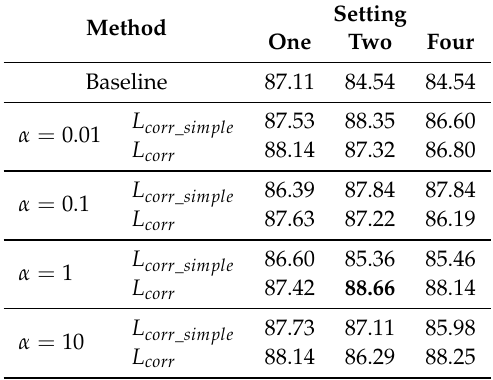
Table 4. The performance of audio-visual emotion recognition with different settings on the eNTERFACE’05